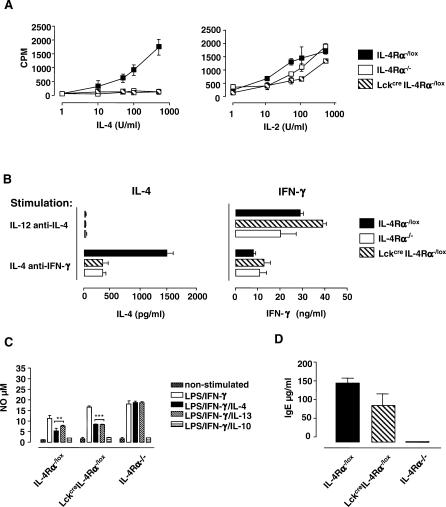
Functional Analysis of LckcreIL-4Rα−/lox Mice(A) Impaired proliferation in response to IL-4. [3H] thymidine incorporation by CD4+ T cells stimulated by serial dilutions of rIL-4 (left panel) or IL-2 (right panel). One of three representative experiments is shown with means of triplicate values ± SD.(B) Impaired Th2 differentiation of CD4+ T cells. CD4+ T cells were cultured in Th1 or Th2 polarizing conditions and IL-4 or IFN-γ secretion was measured by ELISA. A representative of one of three experiments is shown with means of triplicate values ± SD.(C) IL-4 and IL-13 suppress macrophage NO secretion in LckcreIL-4Rα−/lox mice. Peritoneal exudate cells were incubated with IL-4, IL-13, or IL-10 in combination with LPS/IFN-γ, LPS/IFN-γ alone, or medium alone. Nitrite levels were measured by Griess reaction. One of three experiments is shown with means of triplicate values ± SD. (**p < 0.01 or ***p < 0.001, LPS/IFN-γ versus LPS/IFN-γ + IL-4 or IL-13)(D) IgE production. Total IgE was measured in sera taken at 3 wk after infection and boosted with OVA (three mice per group). One representative experiment of two is shown.